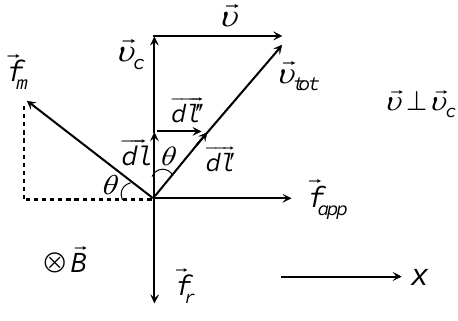
Figure 6: Balance of forces per unit